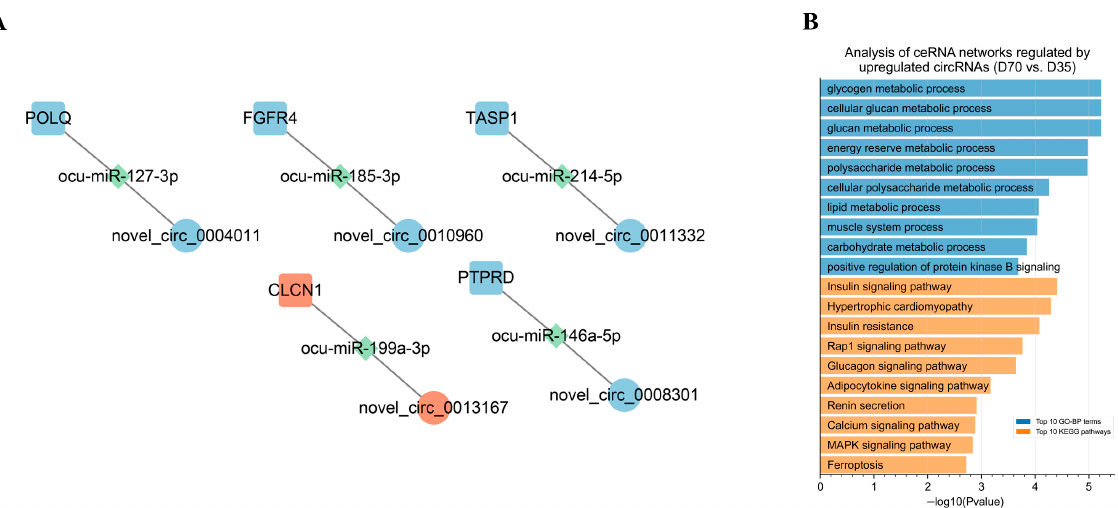
Figure 9. Functional annotation of circRNAs in putative DEC–DEmiRNA–DEmRNA networks from D35 to D70. ( A ) From D35 to D70, the circRNAs regulate host genes by interacting with miRNAs. The red and blue nodes indicate the upregulated and downregulated genes, respectively. ( B ) GO